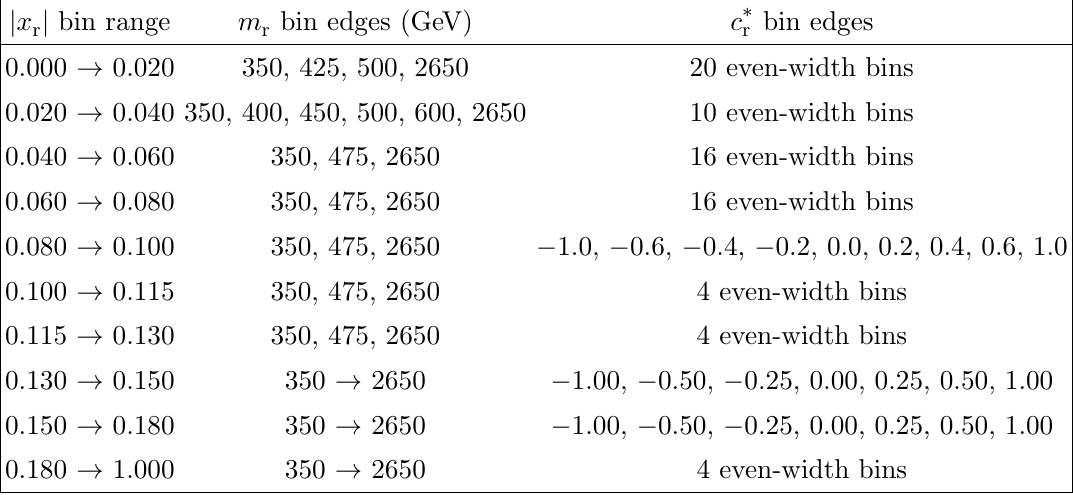
Table 7 . Template binning in the type-3 m +jets signal regions (each template has 222 total bins). j x j bin range r